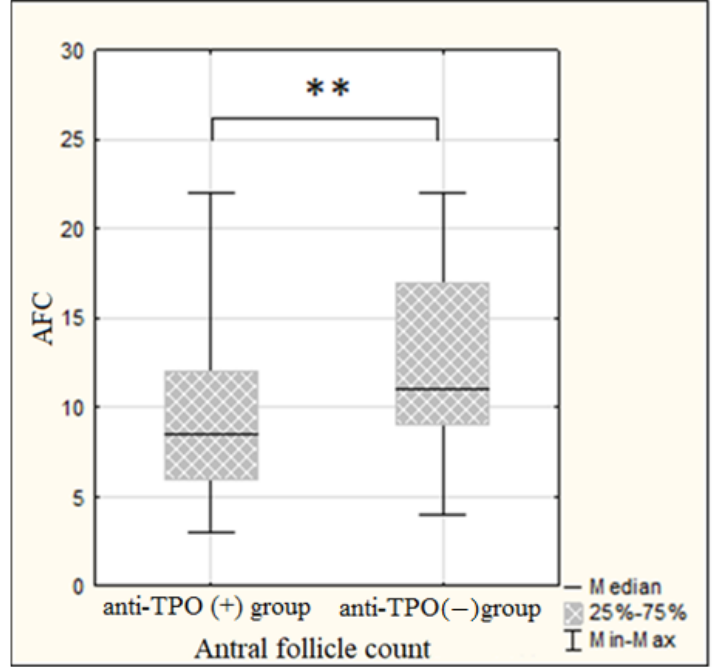
Figure 3. Comparative analysis of antral follicle count in the groups investigated. Mann–Whitney U-test, ** p < 0.01. AFC—antral follicle count. When analyzing an association between follicular fluid AT-TPO and ovarian reserve characteristics, a negative correlation was determined both with serum AMH (Rs = − 0.272, p = 0.017) and antral follicle count before the start of controlled ovarian stimulation (Rs = − 0.319, p = 0.0022).